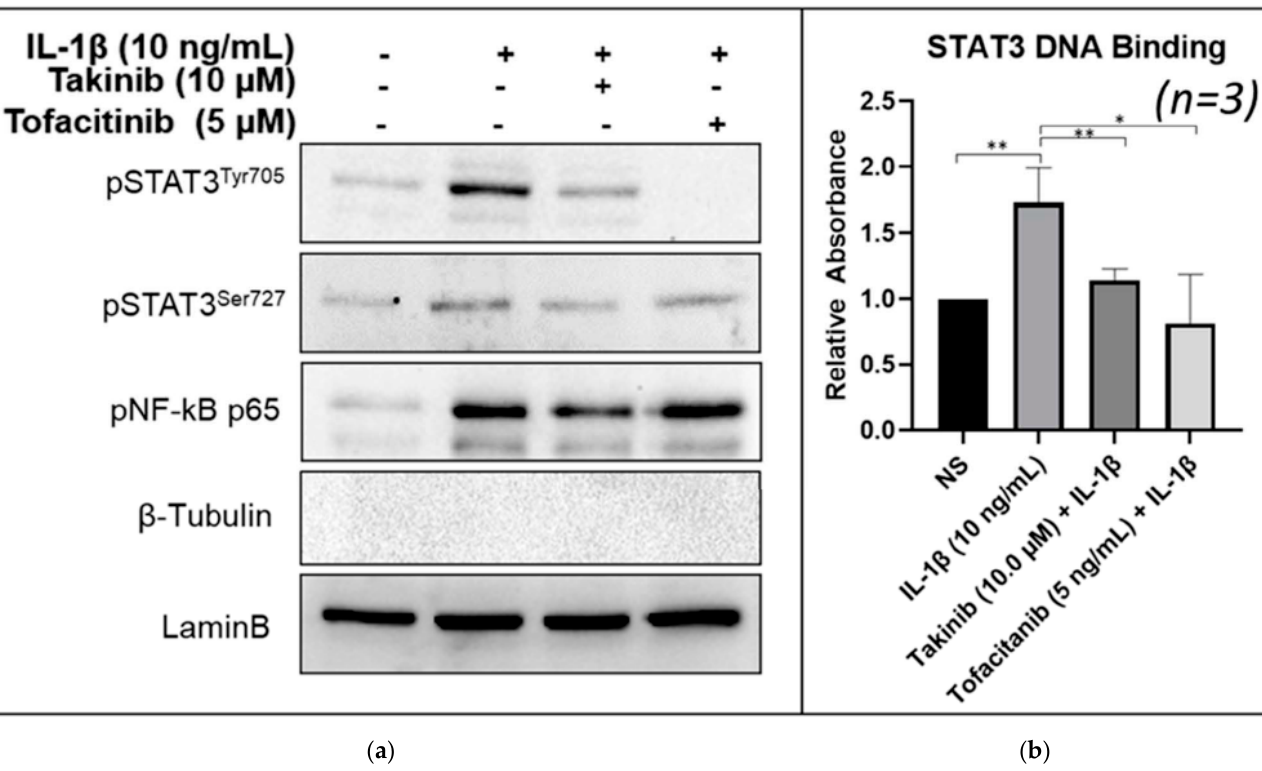
Figure 3. Treatment of RASFs with takinib or Tofacitinib and IL-1 β reduces nuclear phospho-STAT3 Tyr705 and STAT3’s DNA-binding ability. ( a ) RASFs were pre-treated with takinib or tofacitinib followed by 30 min stimulation with IL-1 β (10 ng/mL). Purified nuclear extracts from n = 3 cell lines were collected and analyzed by Western Blot. In n = 3 RASF cell lines. ( b ) RASFs were pre-treated with takinib followed by 30 min stimulation with IL-1 β (10 ng/mL). Nuclear extracts analyzed by ELISA show reduced DNA binding activity in n = 3 RASF cell lines treated with takinib and tofacitinib. * = p < 0.05, ** = p < 0.001.